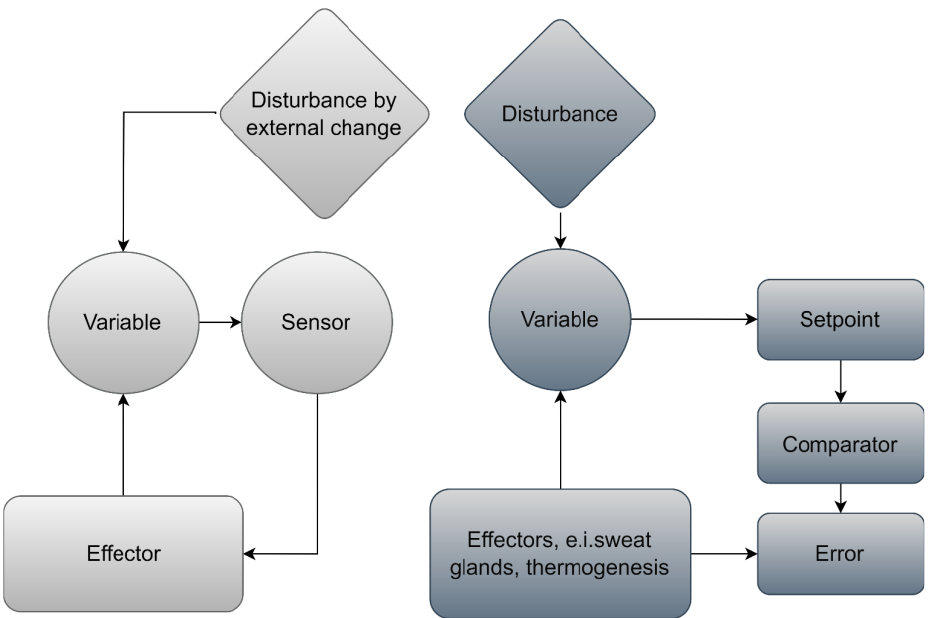
Figure 2. Principles of feedback control in a simple and complex feedback system, adapted from Willmer et al. (2009, p. 34) [28].